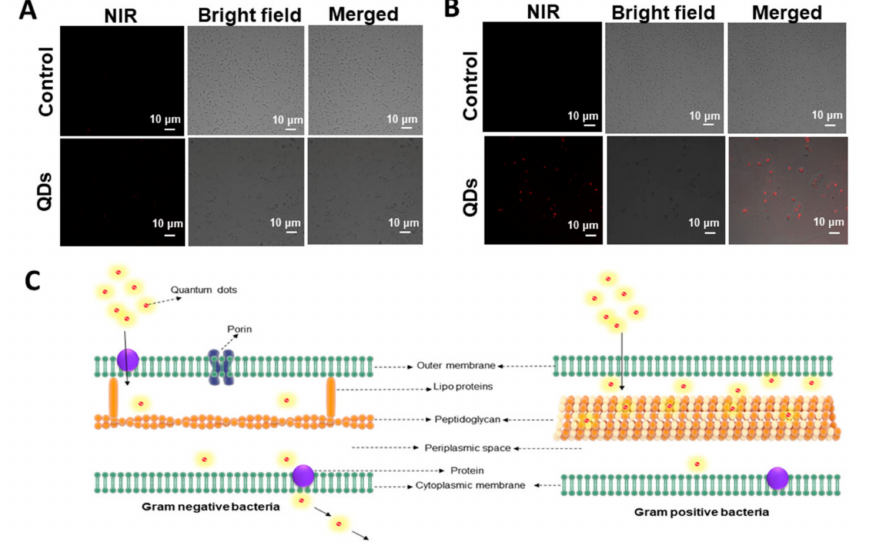
Figure 4. Confocal microscopy images showing the uptake of AgInSe/ZnS QDs in ( A ) Staphylococcus aureus (Gram-positive bacteria) and ( B ) Escherichia coli (Gram-negative bacteria). ( C ) A possible mech- anism for the differential uptake of AgInSe/ZnS QDs in Gram-positive and Gram-negative